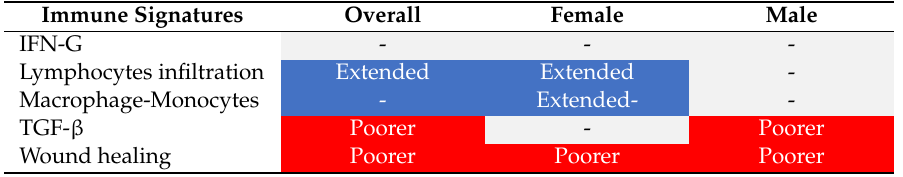
Table 2. Prognostic value of enriched immune signature expression for LUAD patients. Immune Signatures Overall Female Male IFN-G - - - Lymphocytes infiltration Extended Extended -